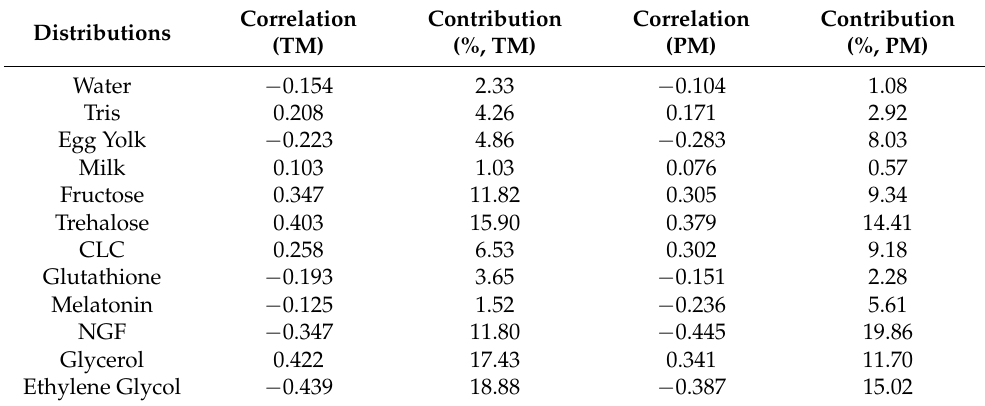
Table 4. Correlations between components and total motility (TM), progressive motility (PM), and the sensitivity analyses using the Monte Carlo simulation.